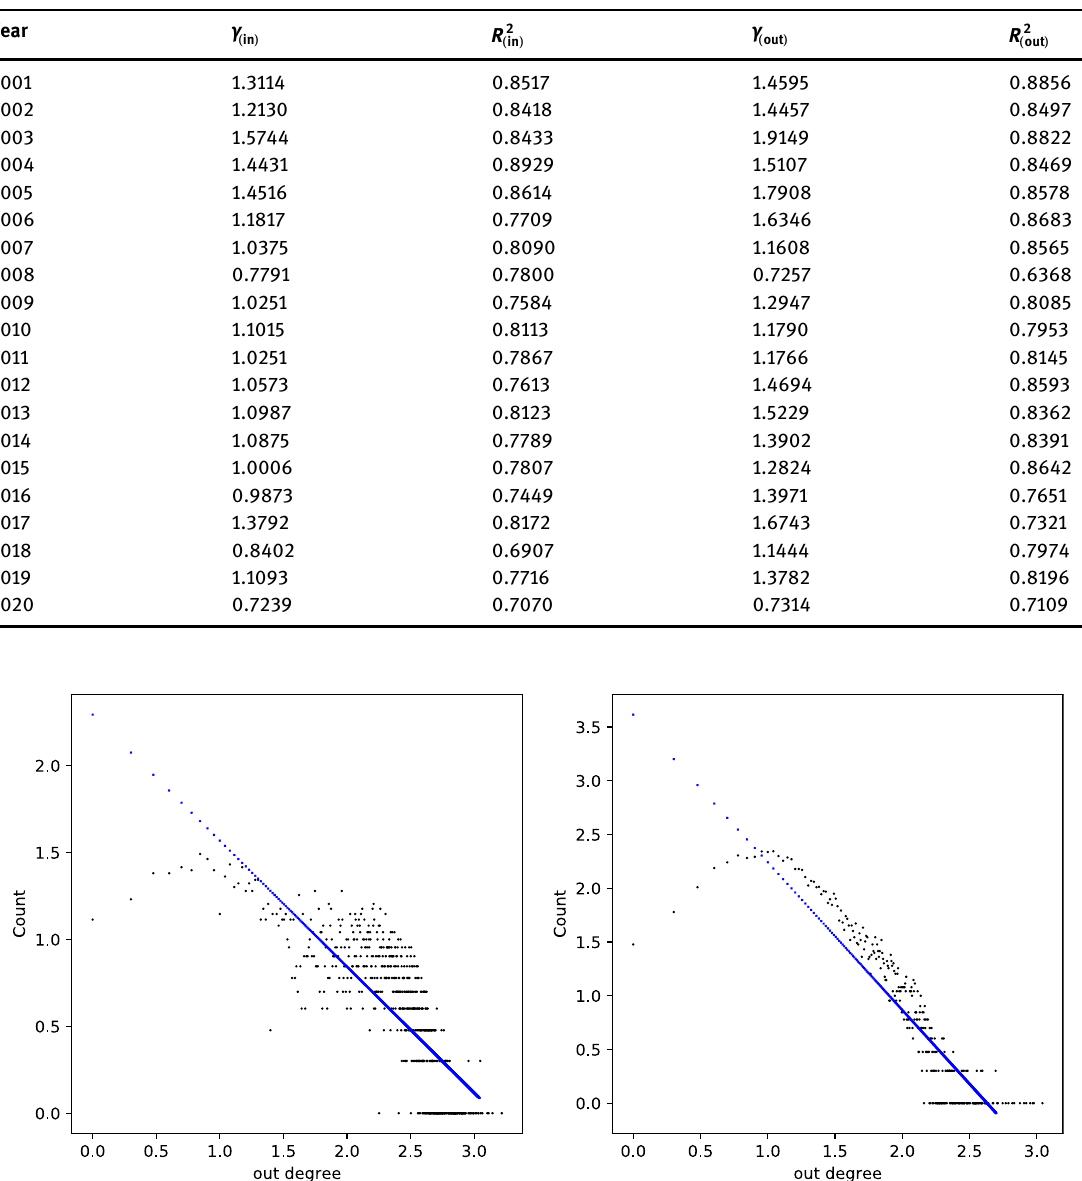
Table 3: Power - law fi t results for in - degree and out - degree distributions